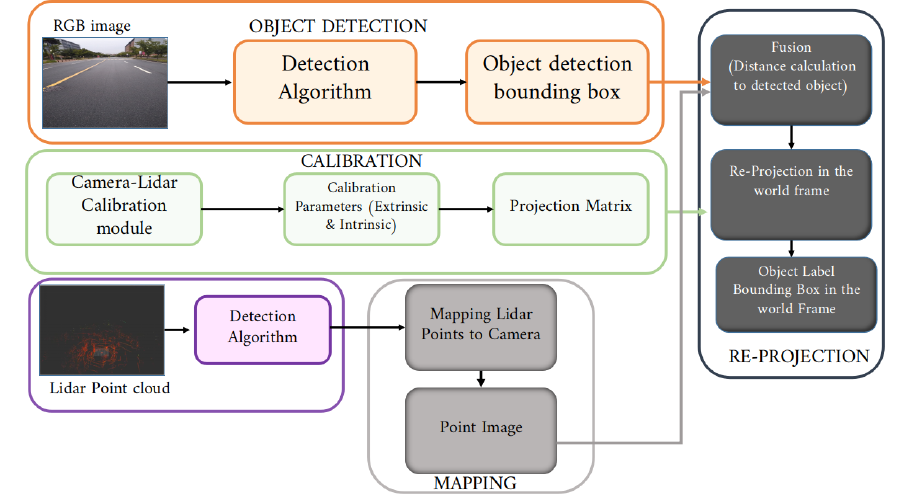
Figure 7. The overall architecture of the calibration and re-projection process is shown. The process is divided into steps. (i) Object detection gives the object detection (ii) Calibration module (iii) The calibration parameters are utilized by the mapping module for generating the point image. (iv) The re-projection module consists of range fusion that performs the distance calculation from the point image and object detection proposal in images and finally computes the object labels bounding box in the Lidar frame (Best viewed in